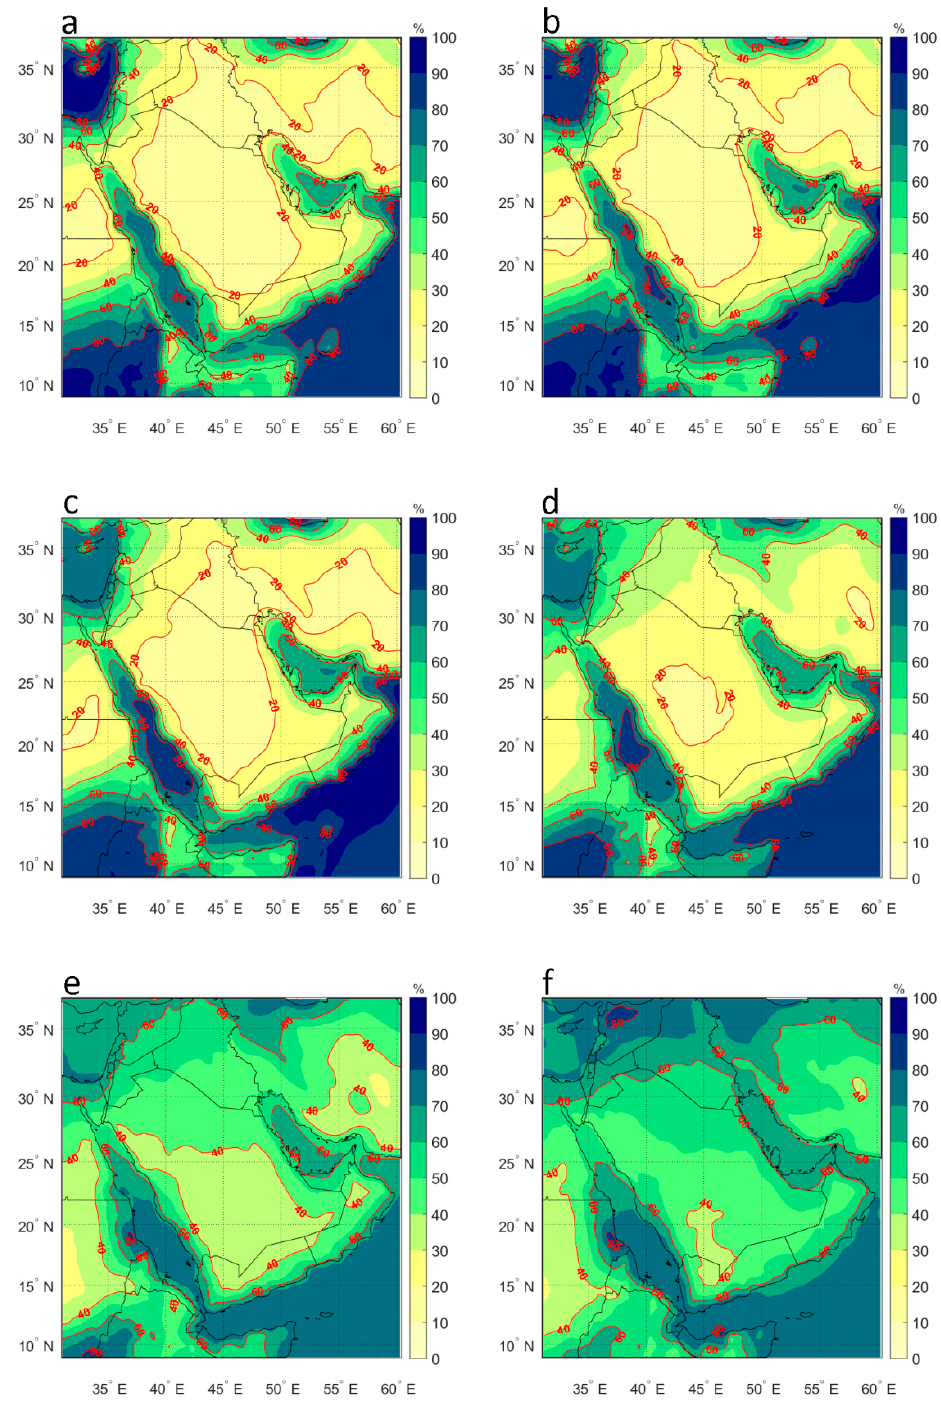
Figure A8. Mean relative humidity for the months July to December ( a – f ).